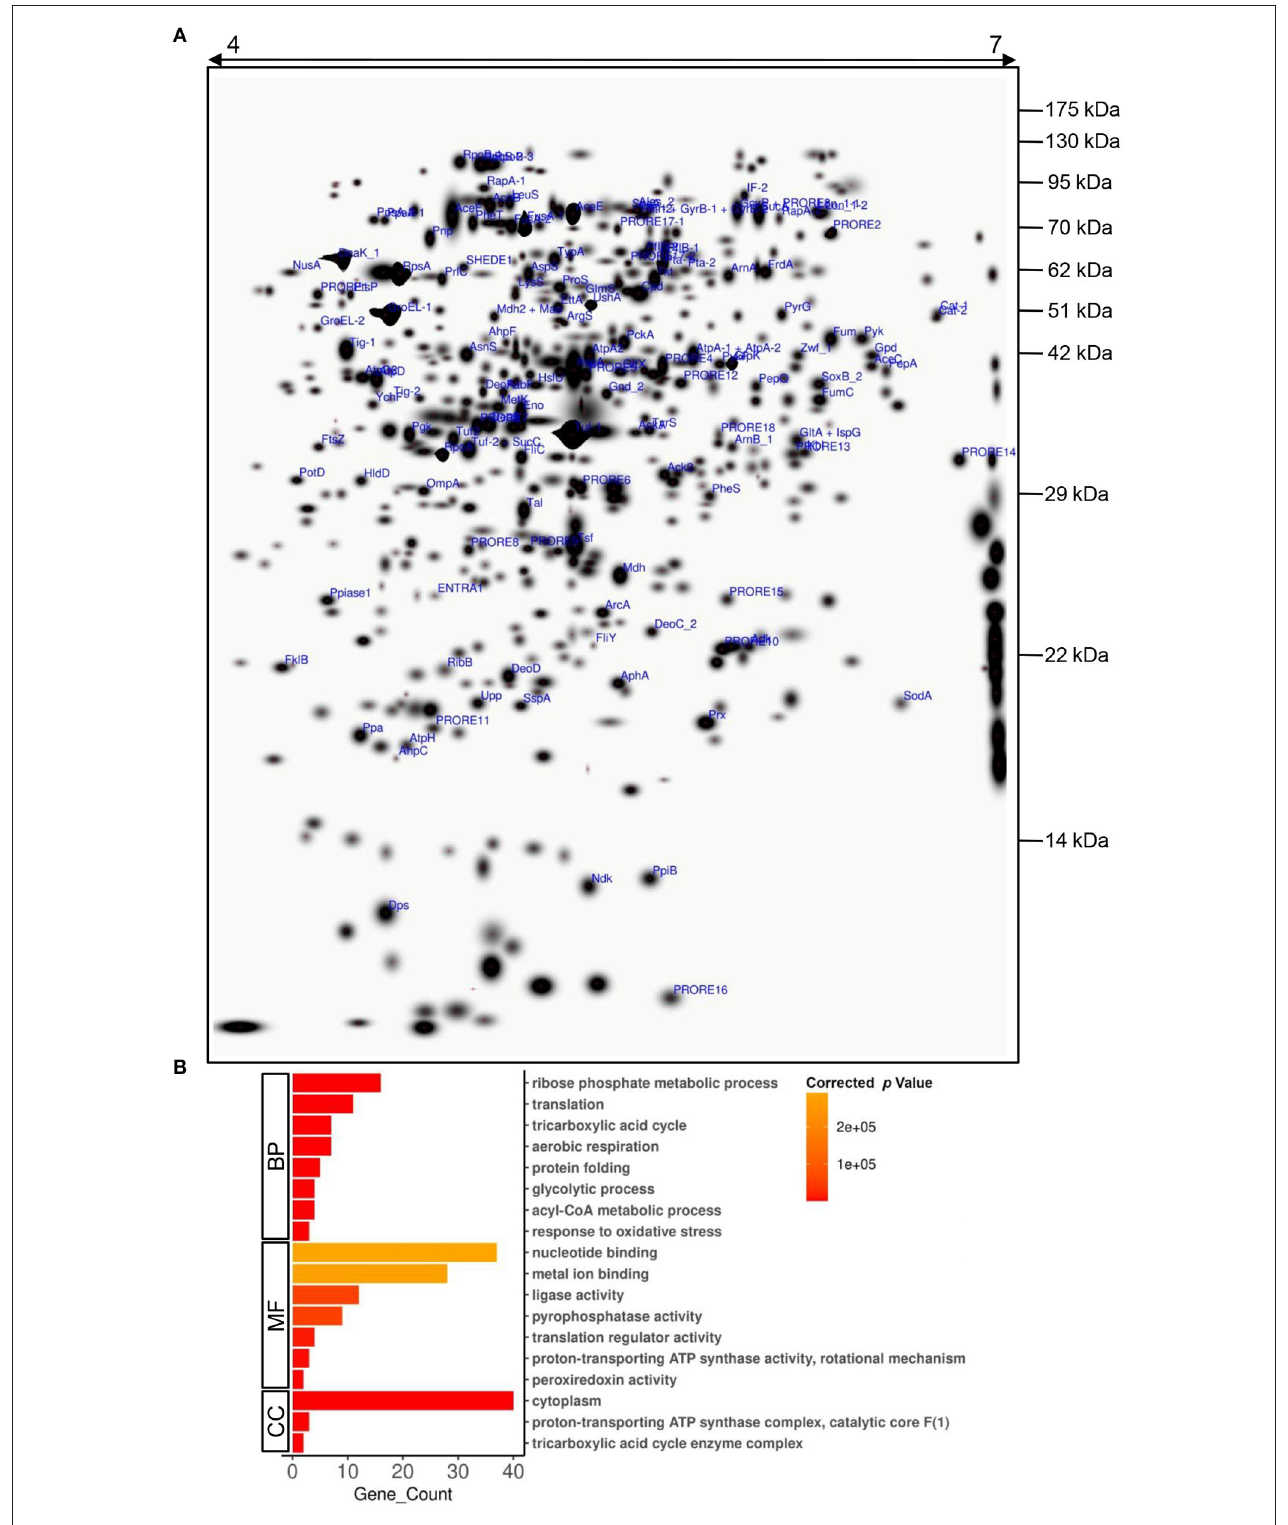
FIGURE 2 | A 2D proteome map of P. rettgeri . (A) A “master gel” representing a proteome of P. rettgeri control cells was created in silico from three biological replicate gels. The pI and molecular masses (kDa) of marker proteins are shown at the top and on the right-hand side of the gel, respectively. All the identified proteins are marked. Refer to Supplementary Table S2 for spot ID annotations. (B) Gene Ontology (GO) functional classification of identified proteins using BiNGO tool. BP, biological process; MF, molecular function; CC, cellular component.